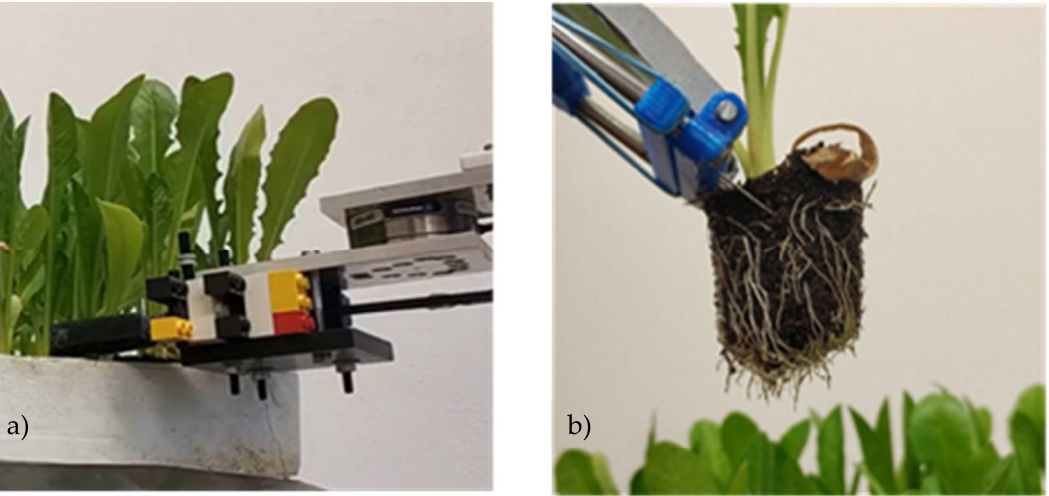
Figure 4. The two gripper typologies grasping chicory seedlings. ( a ) two-finger gripper; ( b ) needle gripper.